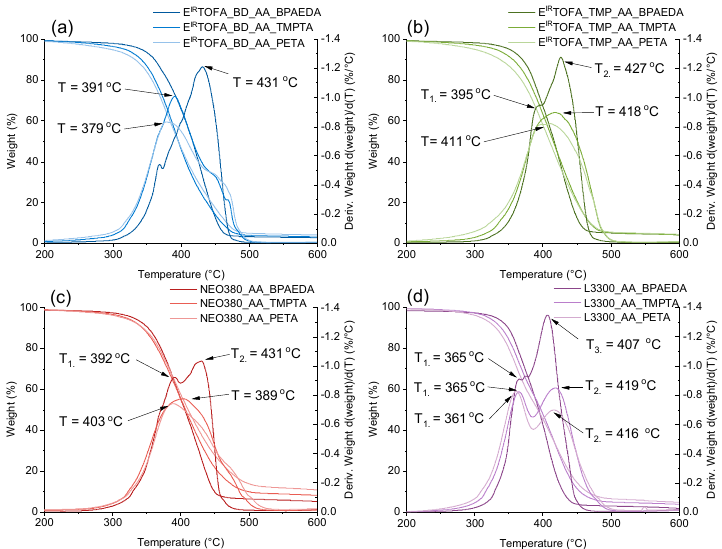
Figure 5. TGA mass loss curve of polymer monoliths from synthesized acetoacetates and BPAEDA, TMPTA, PETA acrylates, and derivative of the mass loss. ( a ) E IR TOFA_BD_AA polymers; ( b ) E IR TOFA_TMP_AA polymers; ( c ) NEO380_AA polymers; ( d ) L3300_AA polymers.